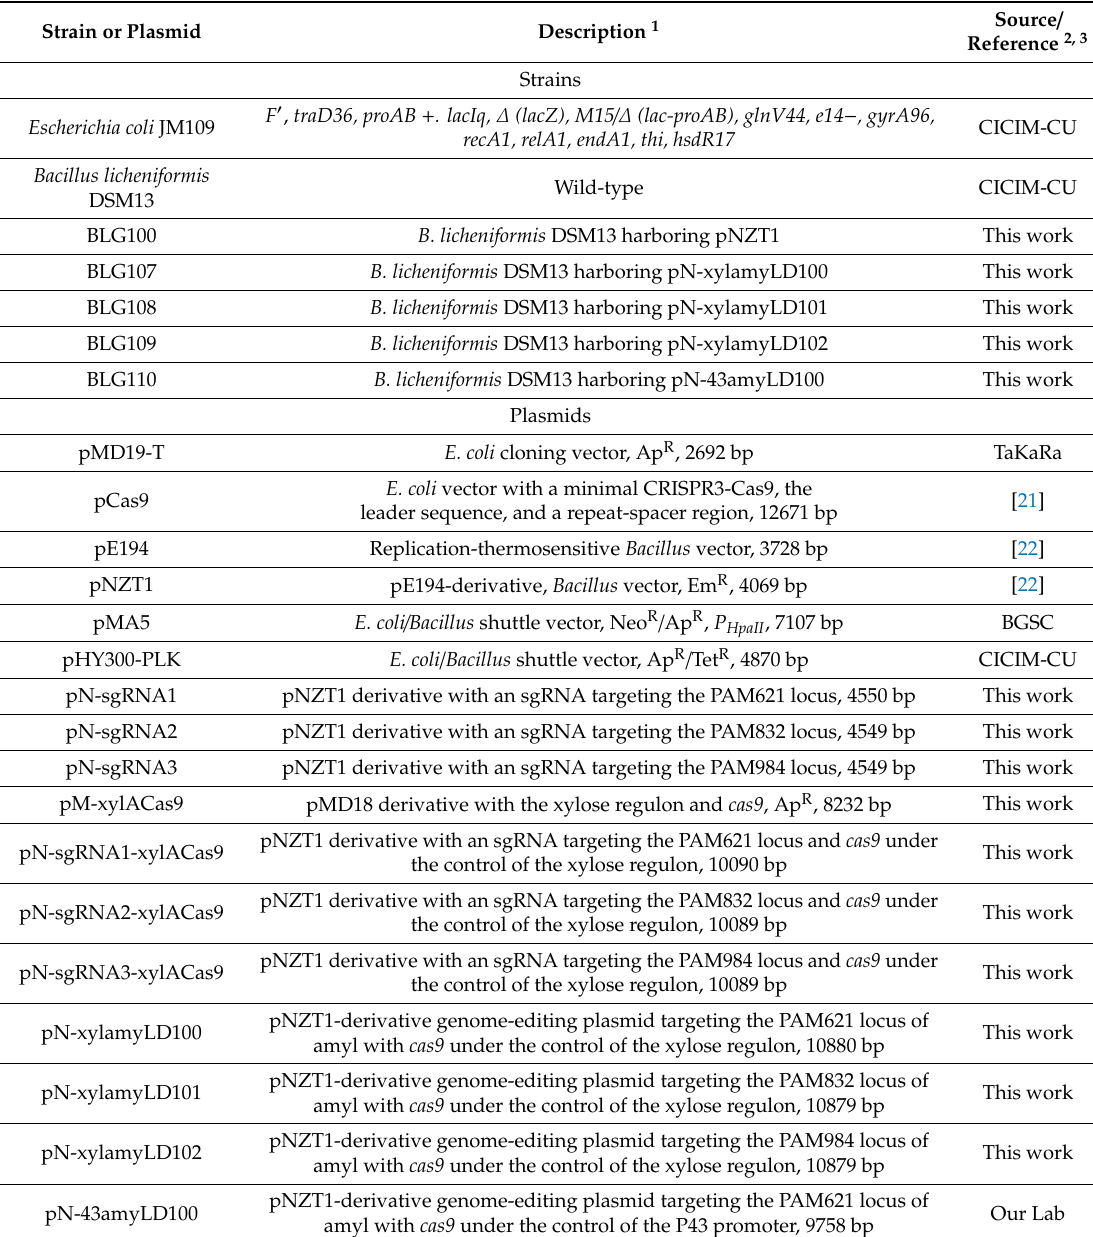
Table 1. Bacterial strains and plasmids used in this